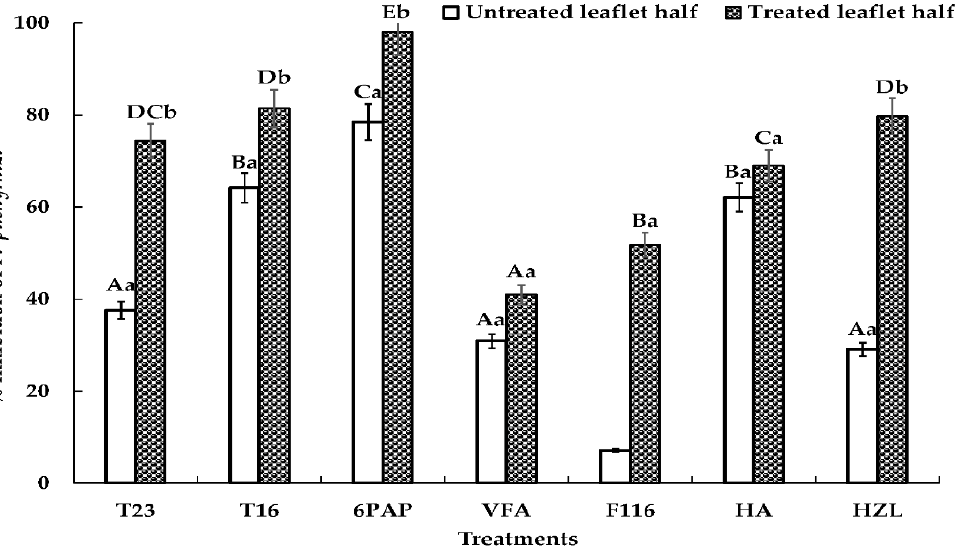
Figure 4. Effects of treatments with conidial suspensions or SMs of Trichoderma spp. applied 24 h in advance of P. pachyrhizi inoculation on the percentages of uredia covered areas (UCAs) of soybean leaves. Different uppercase letters indicate significant differences among treatments within the same half of the leaf, while different lowercase letters indicate significant differences between treated and untreated halves of the same leaf using LSD test at p = 0.05.